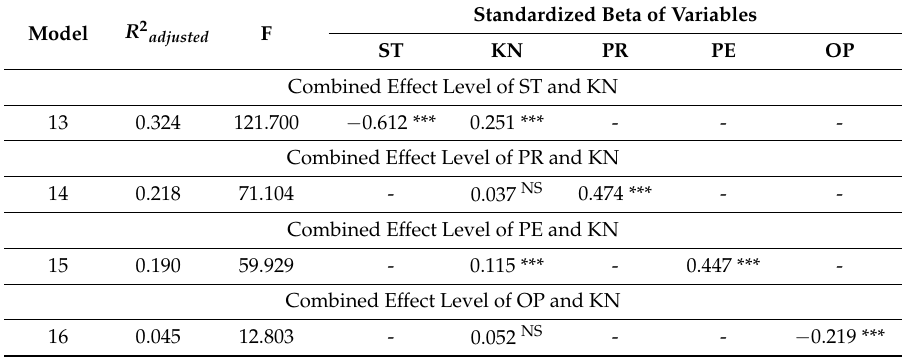
Table 6. Summary of combined effect levels on anxiety by multiple linear regression analyses of knowledge and social trust, perceived risk, pessimism, optimism, respectively.